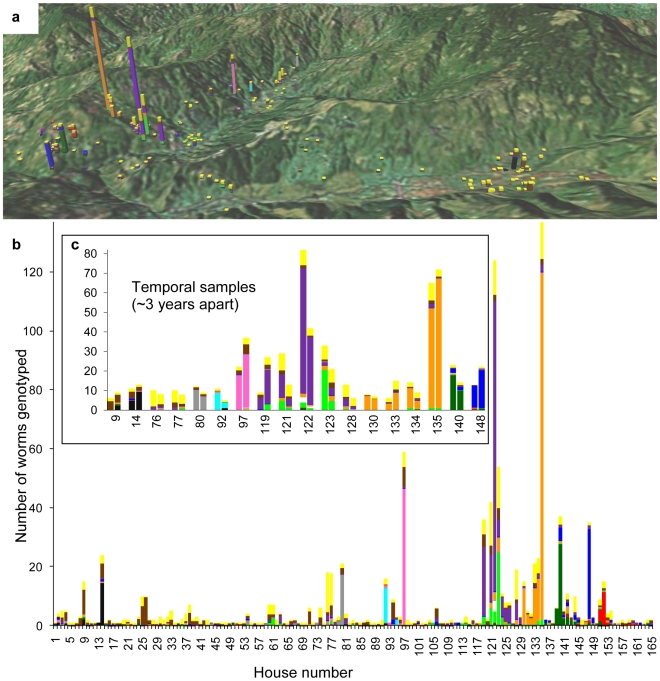
Distribution of A. lumbricoides genetic clusters in Jiri, Nepal.Each bar is a house and the height is the number of genotyped worms from that house. Colors within each house show the proportion of worms from the 13 core genetic clusters identified by structure. The latter was generated by summing the Q-values of individual worms within houses. (A) The geographic location of each house is illustrated over the landscape of the village. (B) The same information as in (A) but is linear to show full coloration of each house. (C) Displays the houses that could be tested for changes in parasite genetic composition over the two temporal samples (∼3 years apart). After correction for multiple comparisons, no household showed a significant change in parasite genetic composition. As an example to illustrate the house effect, house #97 had 59 genotyped worms (B), 22 and 37 from the two temporal samples (C). House 97 consisted of 77% of the pink genetic cluster and accounted for over 85% of the pink cluster in all the data. These results were obtained with k set to 15. Figure S4 shows the distribution of genetic clusters for k = 5.